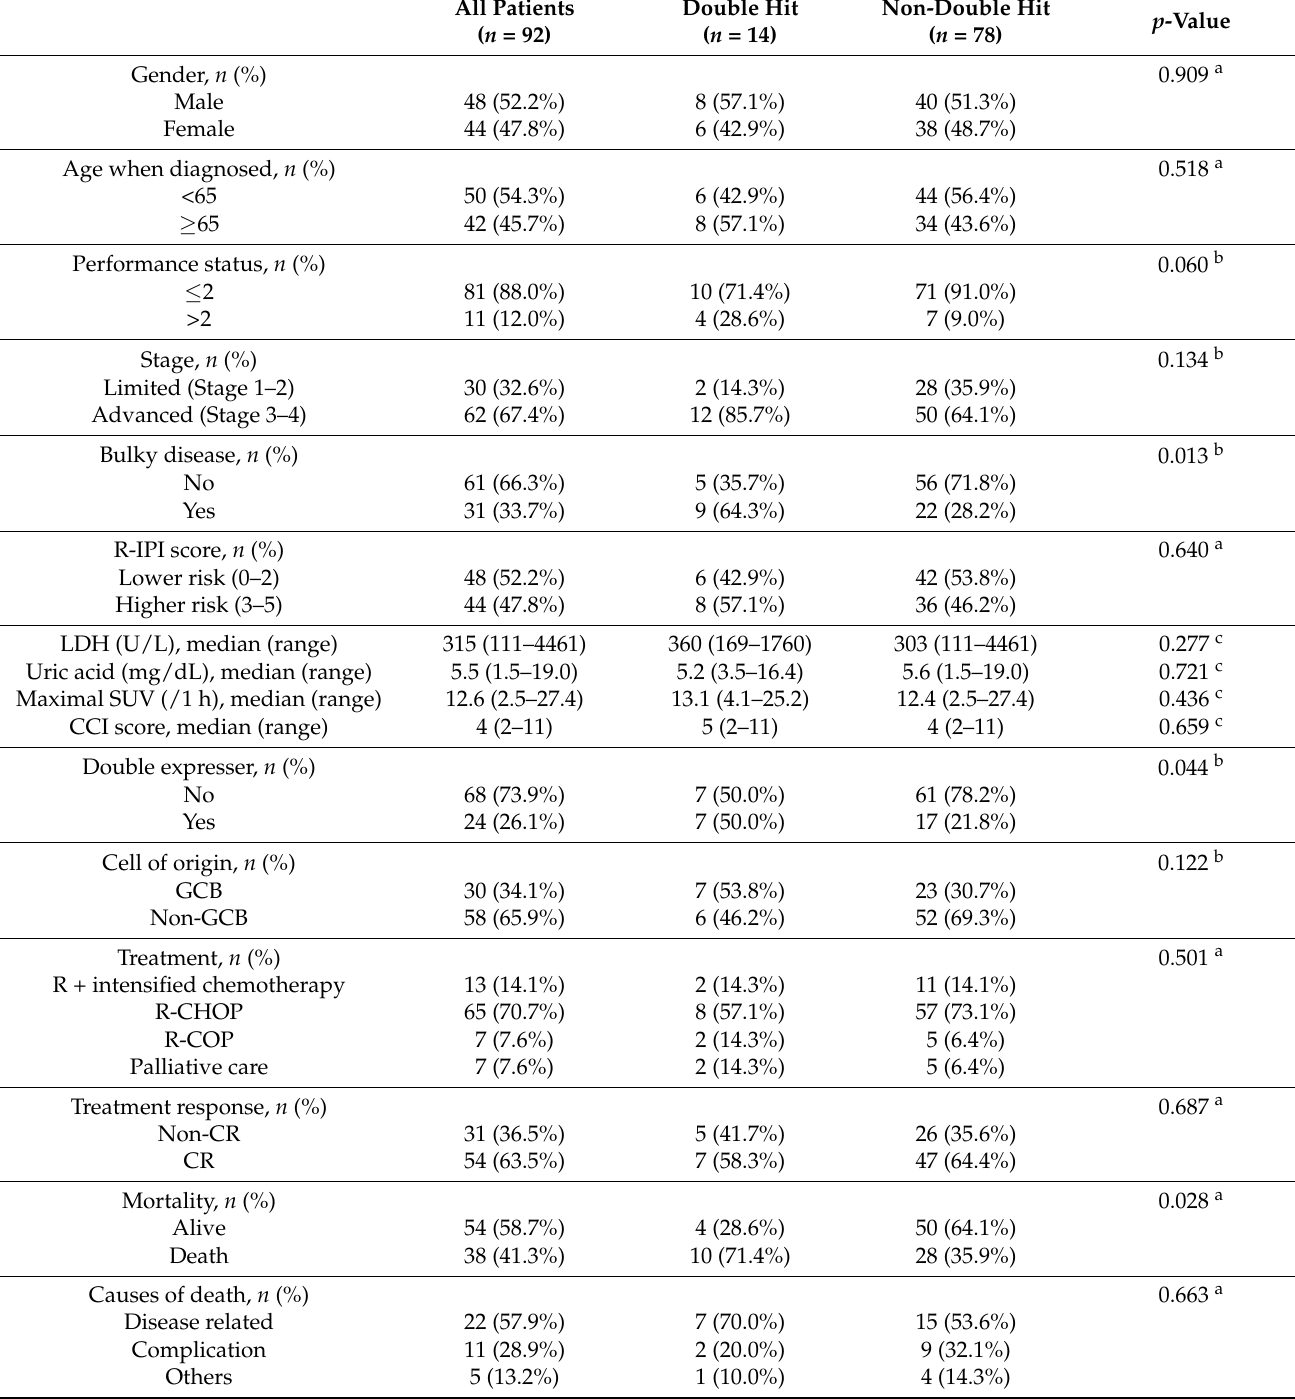
Table 1. Patients’ characteristics and comparison of